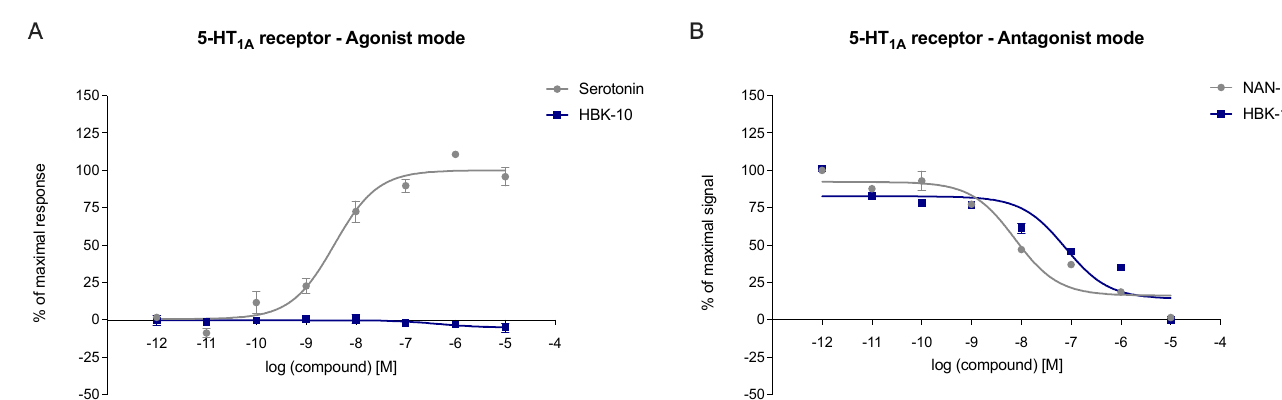
Figure 2. The activity of HBK-10 at 5-HT 1A receptors in in vitro functional assays (agonist mode: Panel ( A ); antagonist mode: Panel ( B )). Graphs represent dose–response curves for functional activity of the compound in inhibition of cAMP production assay. Table 4. Intrinsic activity of HBK-10 toward the serotonin 5-HT 1A receptor. Agonist Mode Antagonist Mode Treatment